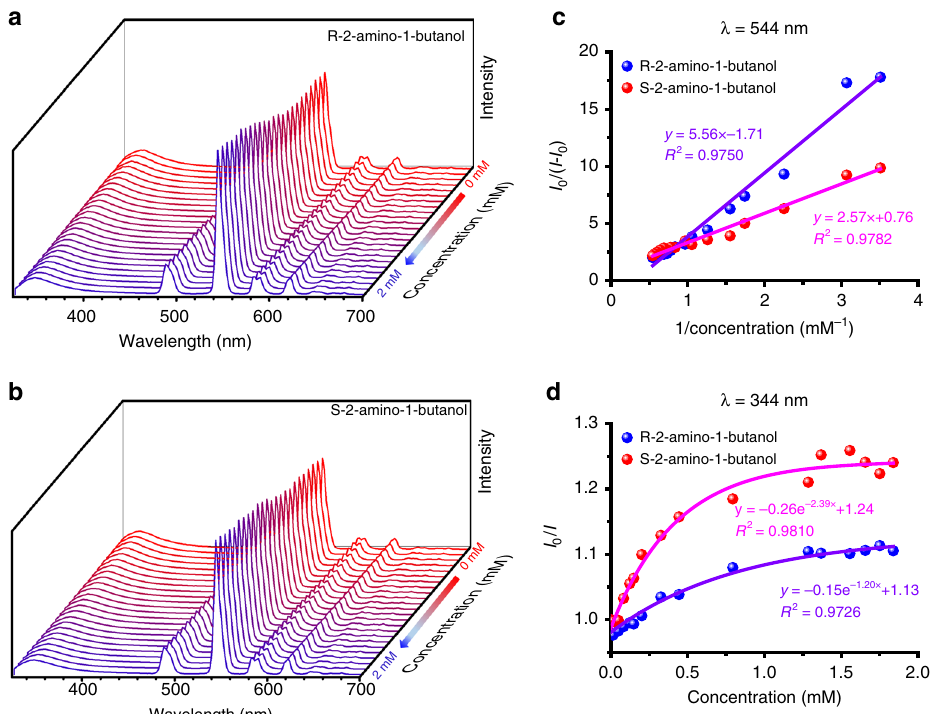
Fig. 5 Emission spectra of Zn-MOF-C-Tb with R/S-2-amino-1-butanol. a , b Zn-MOF-C-Tb dispersed in DMF upon incremental addition of R-2-amino-1- butanol and S-2-amino-1-butanol. c , d Fluorescence intensity changes of Zn-MOF-C-Tb at 544nm and 344 nm. The solid lines are fi tting